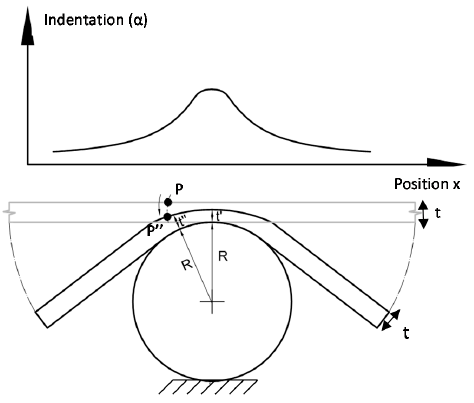
Figure 3. Schematic showing the contact behavior between a plate and a sphere. Detail of the damage generated due to